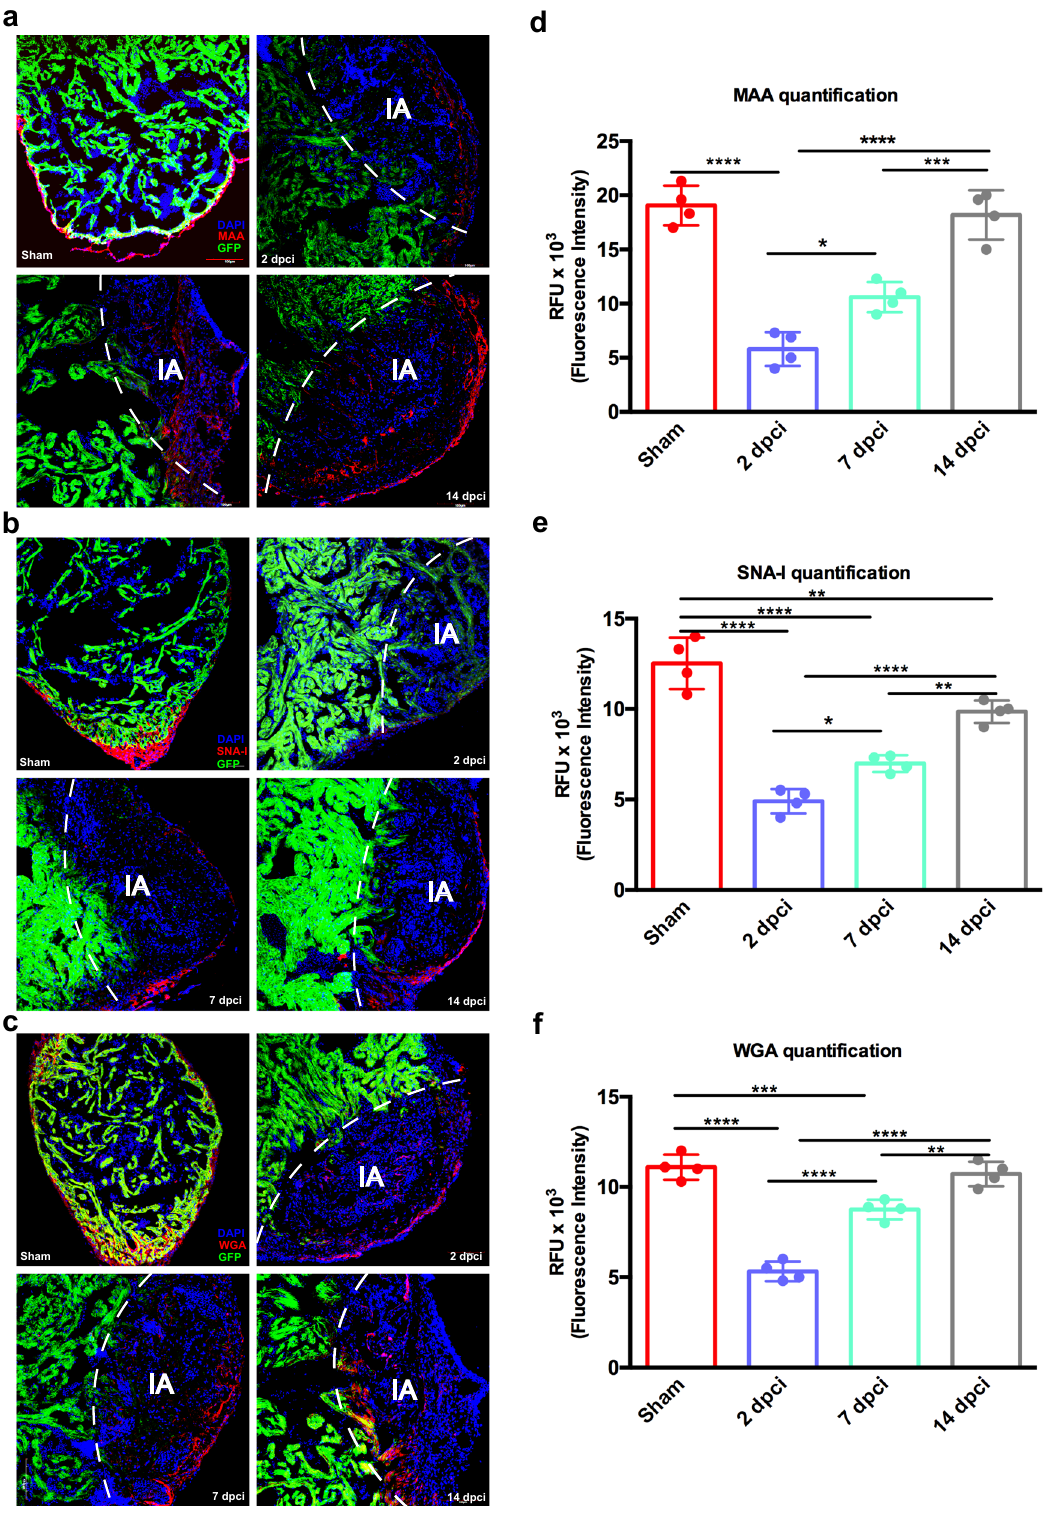
Fig. 4 Sialic acid distribution in regenerating zebra fi sh heart identi fi ed by lectin histochemistry. a Lectin histochemistry showing the distribution of MAA, recognizing α -(2,3)-linked sialic acid, b SNA-I, binding to α -(2,6)-linked sialic acid and c WGA, binding to sialic acid and GlcNAc, in ventricle tissue. d MAA, e SNA-I and f WGA relative quanti fi cation. The lectin binding quanti fi cations highlighted a similar decrease at 2 dpci and a subsequent increase in the following timepoints. Cardiomyocytes were identi fi ed by GFP positivity. IA injured area. Data are shown as mean with SD ( n = 4 animals per group). Scale bar = 100 μ m. * p < 0.05, ** p < 0.01, *** p < 0.001, **** p <